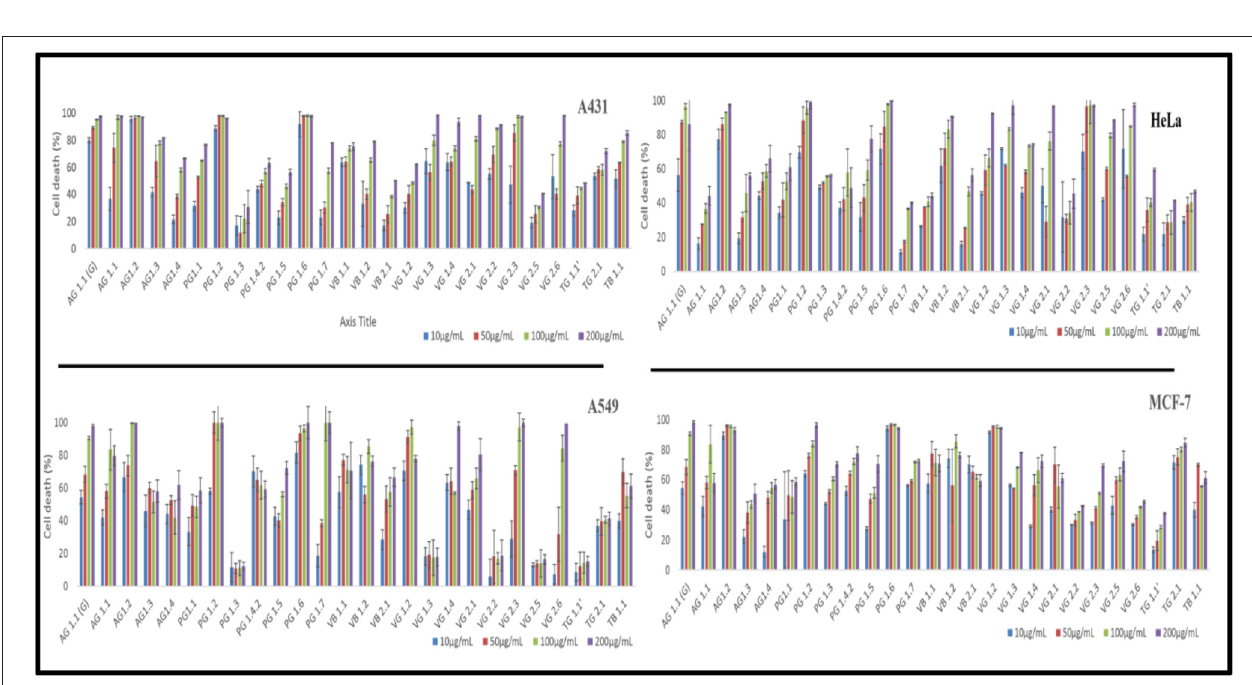
FIGURE 4 | In vitro cytotoxicity of ethyl acetate total culture fungal extracts against A431, HeLa, A549 and MCF-7 cells. Cells were incubated with different concentrations (25, 50, 100, and 200 µ g/mL) of extracts and the cytotoxicity was determined by MTT assay.